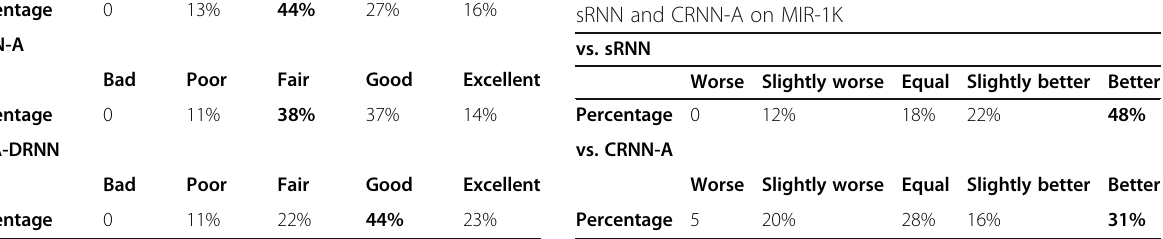
Table 5 Percentages of RPCA-DRNN-separated clips assigned “ worse, ” “ slightly worse, ” “ equal, ” “ slightly better, ” and “ better ” CMOS scores compared with percentages of such scores